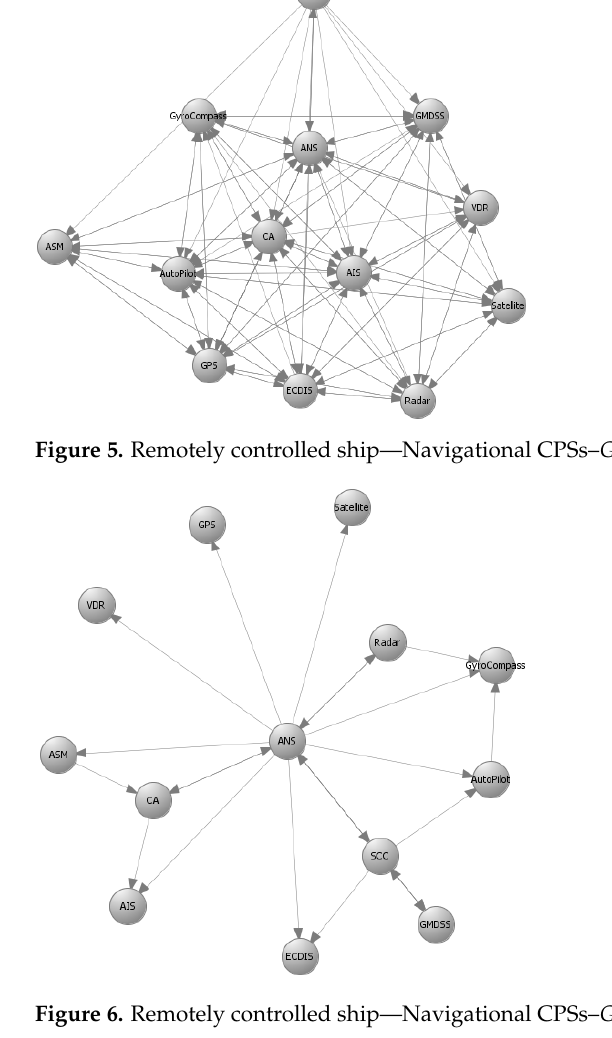
( V , E ) –Control flows. C